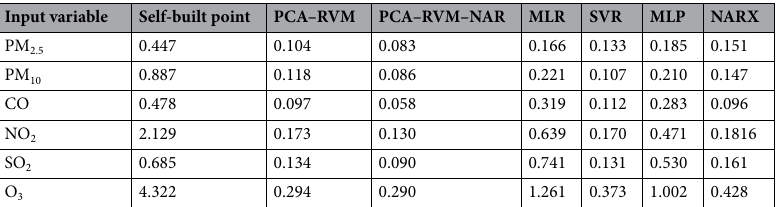
Table 6. The MAPE of self-built point and various air quality prediction models, in which national control point is used as comparison